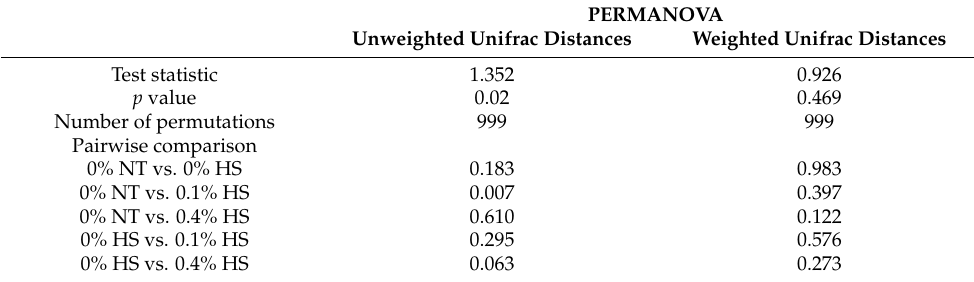
Figure 3. Effects of supplementing diets with solubles from shredded, steam-exploded pine particles (SSPPs) on the cecal microbiota composition assessed from unweighted ( a ) and weighted ( b ) Unifrac distances based on principal coordinate analysis (PCoA) in broiler chickens exposed to either thermoneutral or heat-stress conditions. Chickens were fed with diets containing 0% (control), 0.1%, and 0.4% solubles from shredded, steam-exploded pine particles (SSPPs) from the 8th day to the 36th day of age. On the 37th day, birds were either kept at thermoneutral temperature (21.0 ◦ C) and provided a control diet (0% NT) or heat-stressed at 31.0 ◦ C for six hours and provided a diet supplemented with 0% (0% HS), 0.1% (0.1% HS), or 0.4% (0.4% HS) SSPPs. Number of samples in each treatment (n = 6). Abbreviations: NT, normal temperature; HS, heat stress. The blue circle indicates 0% NT, the red square indicates 0% HS, the orange triangle indicates 0.1% HS, and the green triangle indicates 0.4% HS. Table 5. Effects of supplementing diets with solubles from shredded, steam-exploded pine particles (SSPPs) on the beta diversity (PERMANOVA) as indicated by unweighted and weighted Unifrac distances in broiler chickens exposed to either thermoneutral or heat-stress